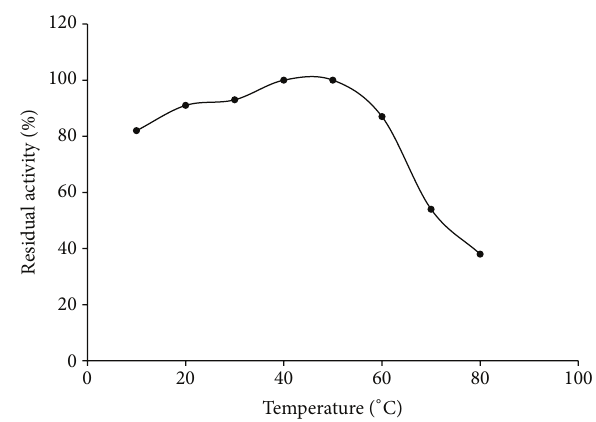
Figure 1: Thermal stability of protease.